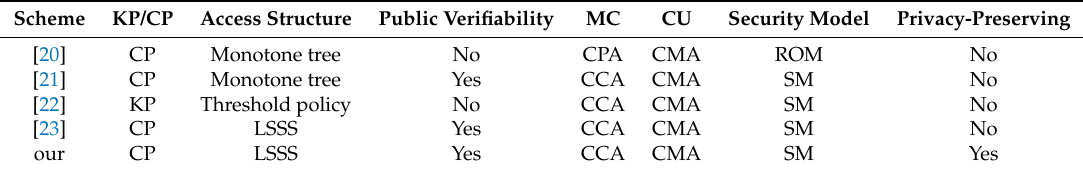
Table 1. Comparison of computation